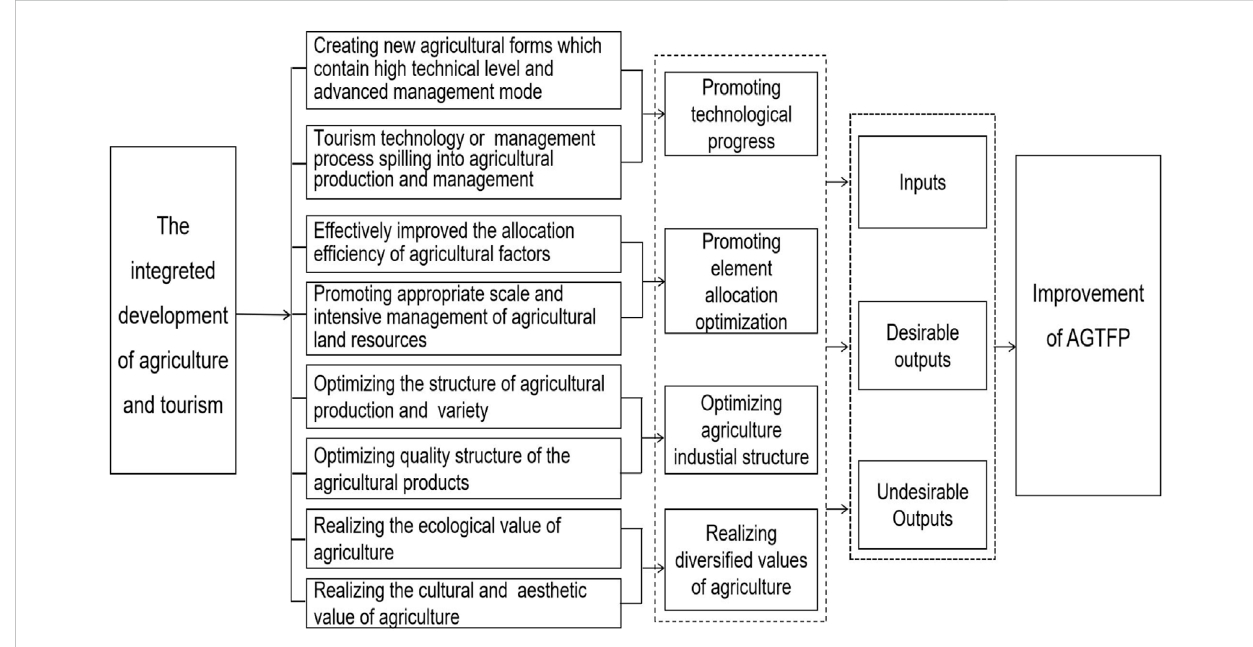
FIGURE 1 Impact mechanism of agriculture – tourism integration on improving